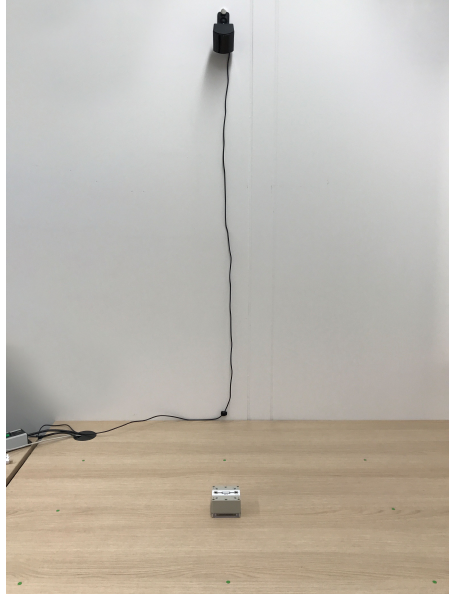
Figure 6. Photo of the experiment setup evaluating the precision of the sensor position on a